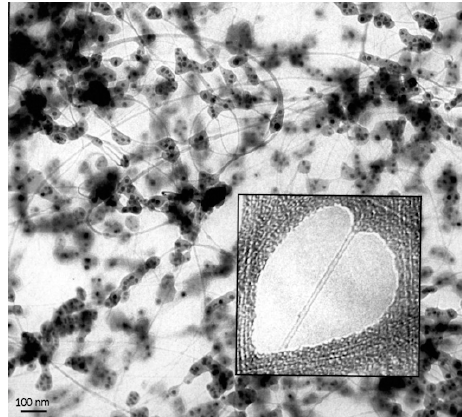
Figure 5. I mages from the work of Bethune et al. showing single-walled carbon nanotubes produced by co-vaporization of graphite and cobalt. Reproduced with permission from [53]. Springer Nature, 1993.